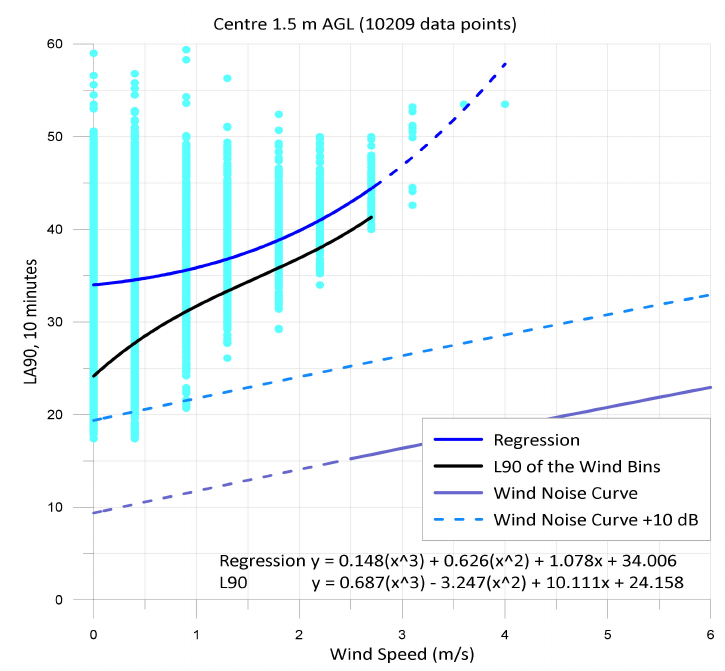
Figure 10. Ambient Regression Line—wind and noise at 1.5 m AGL, in center of field.